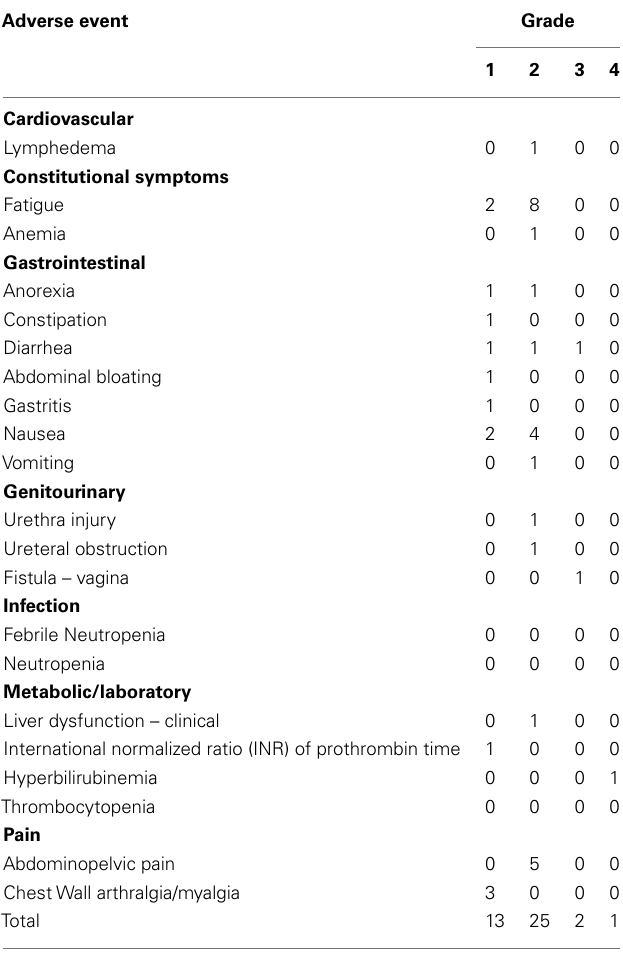
Table 3 | Stereotactic body radiosurgery-related worst grade